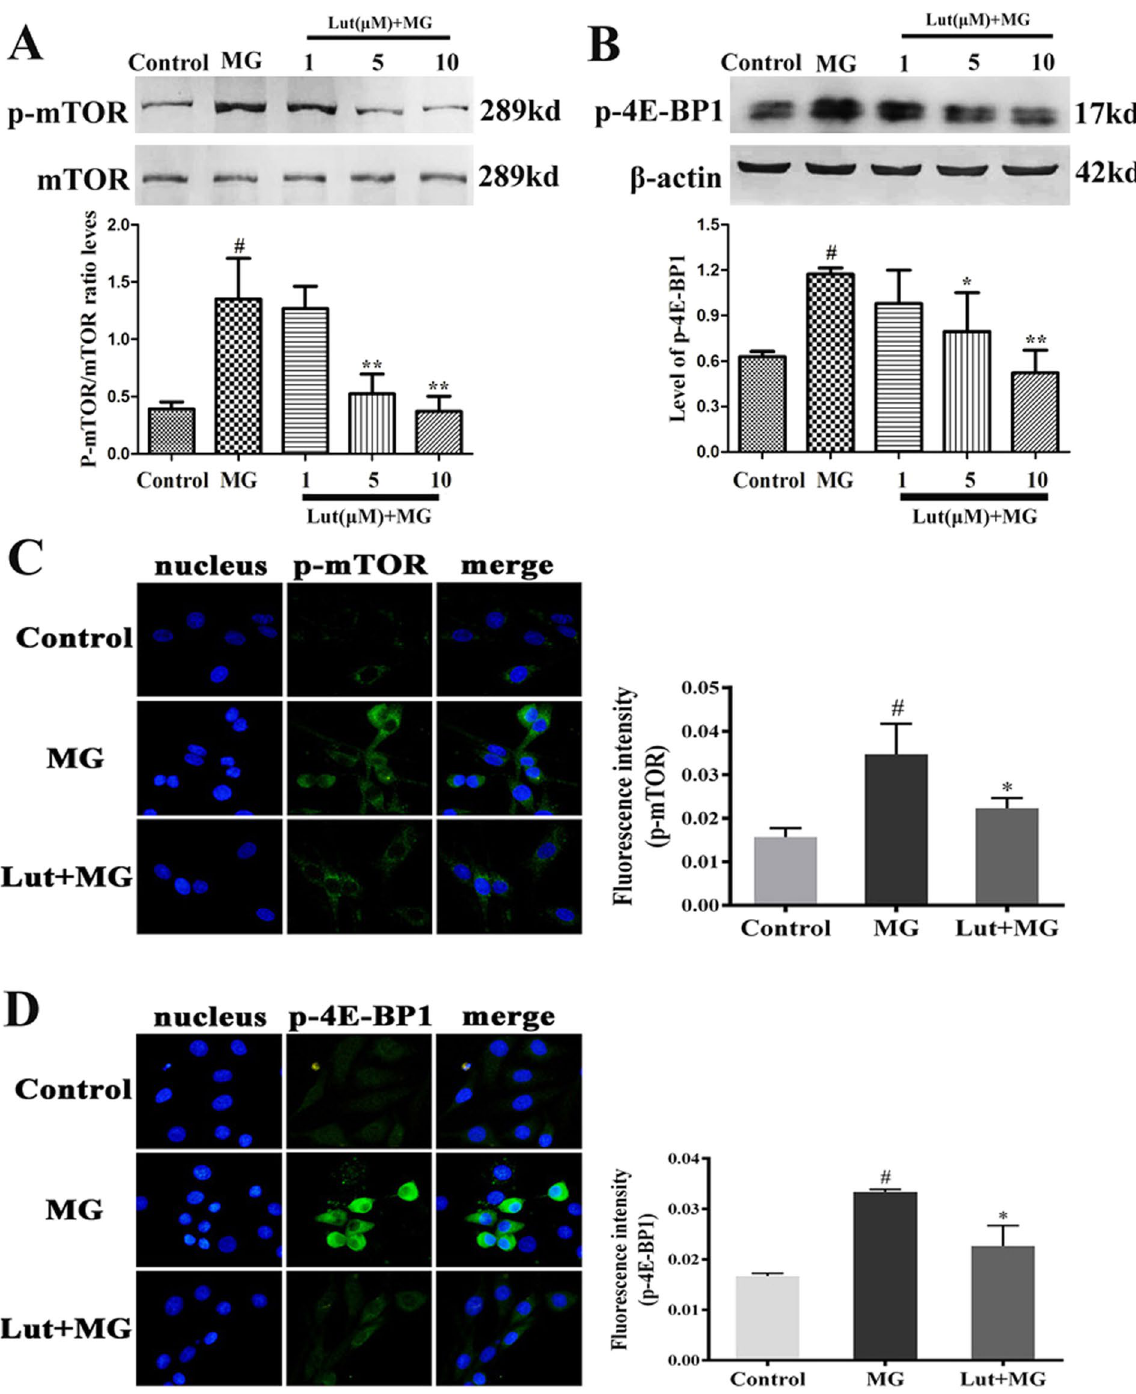
Figure 3. Luteolin (Lut) inhibited the activation of mTOR-4E-BP1 induced by MG. PC12 cells were treated with the Lut (1, 5 and 10 μ M) for 3 h, followed by incubating with 0.5 mM MG for 24 h. The activation of mTOR ( A and C ) and 4E-BP1 ( B and D ) was determined by western blot and immunofluorecence staining. Data are presented as means ± SD of three independent experiments, each performed in triplicate. # p < 0.01 vs control group; * p < 0.05 and ** p < 0.01 vs MG group. The full-length blots/gels are presented in Supplementary Figs S4 and